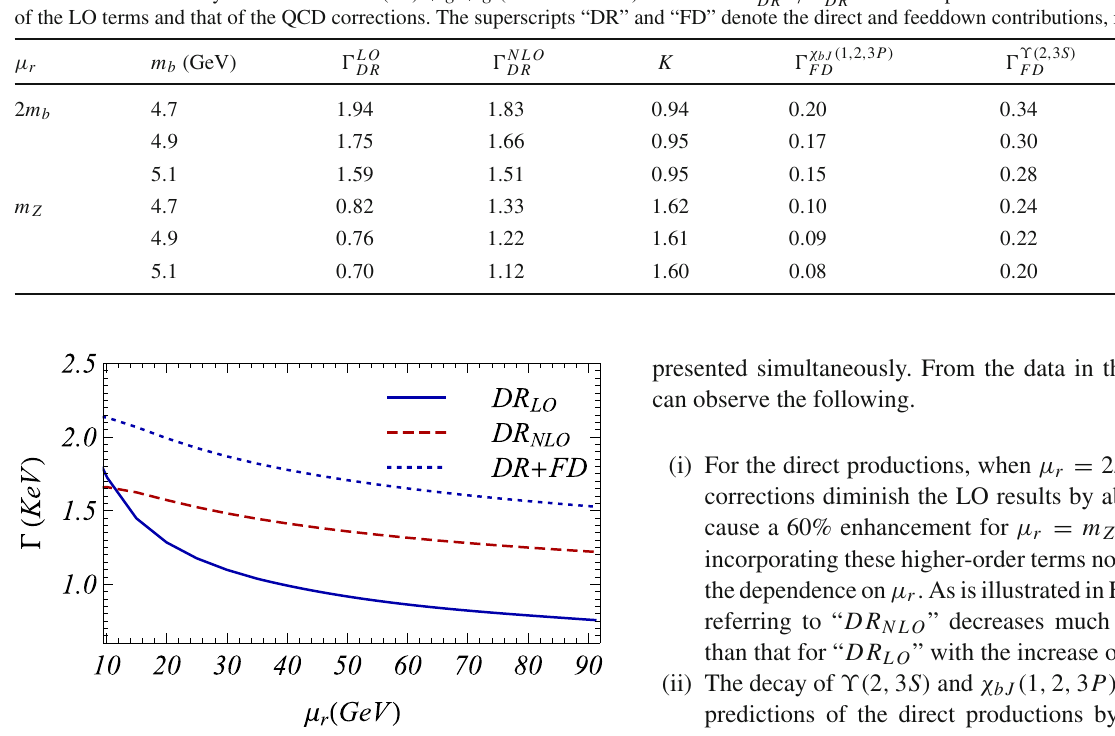
/(cid:6) LO . “NLO” represents the sum of the contribution DR DR